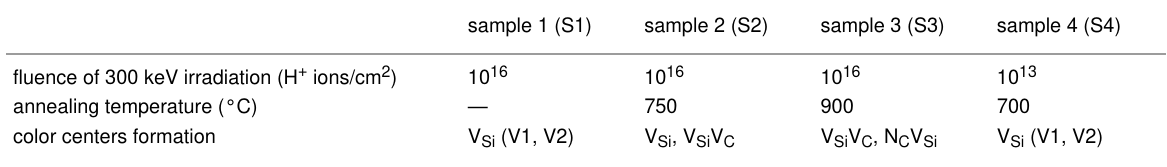
Table 1: Description and predominant PL-measured color centers of each